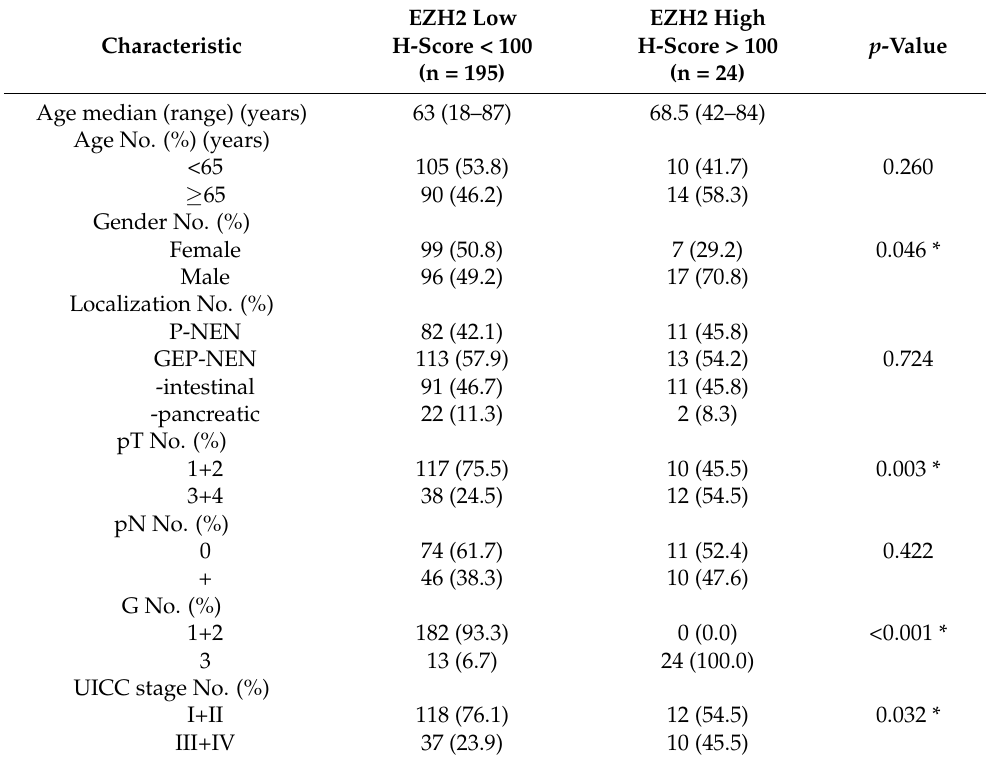
Table 2. Characteristics of enrolled patients depending on EZH2 expression. GEP: gastroenteropan- creatic, NEN: neuroendocrine neoplasia, P: pulmonary, UICC: Union international contre le cancer.